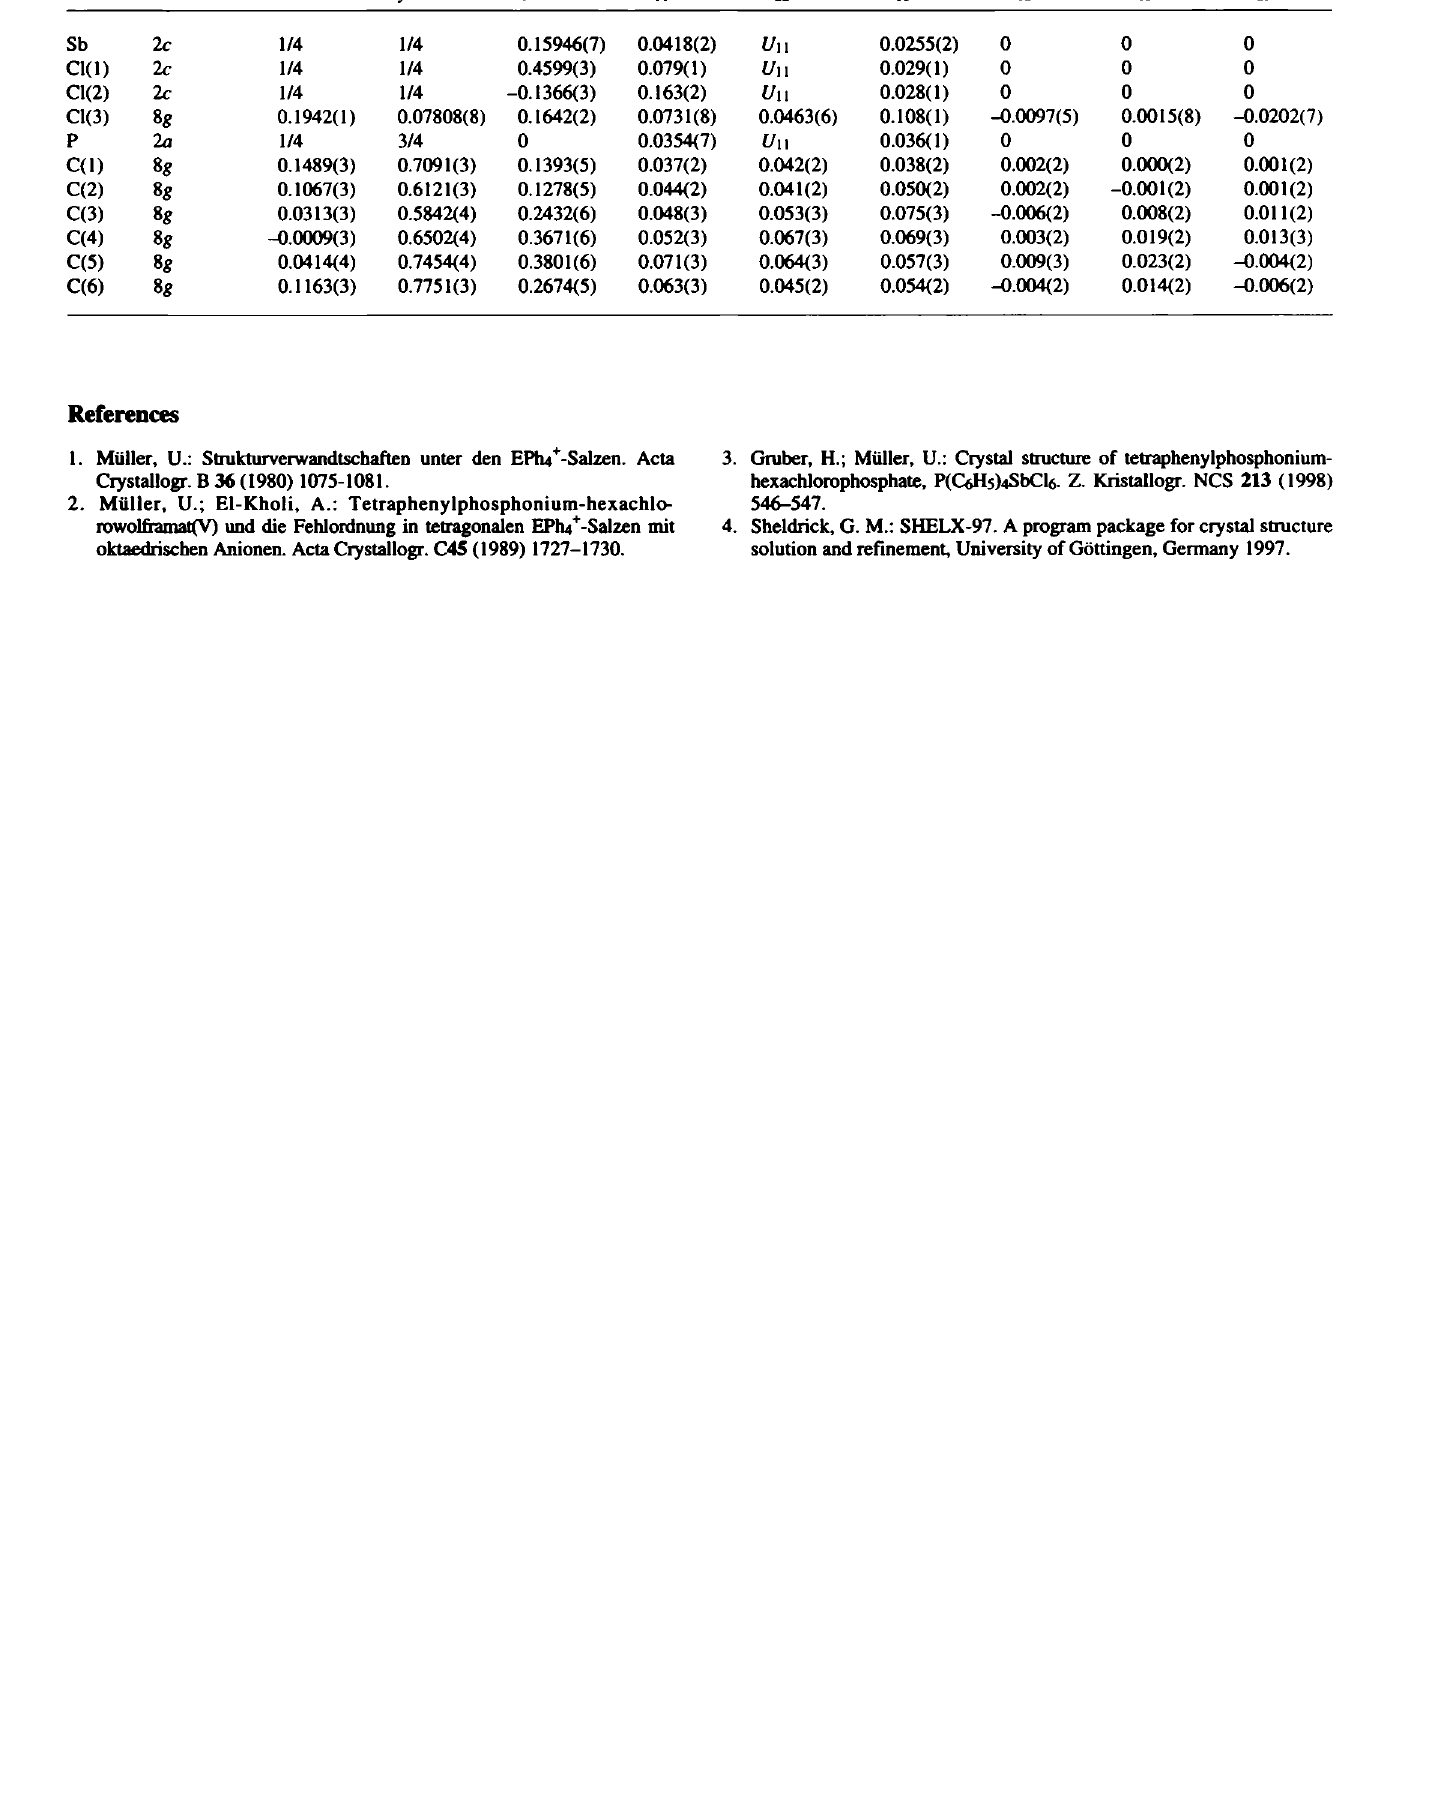
Table 3. Atomic coordinates and displacement parameters (in Ä 2